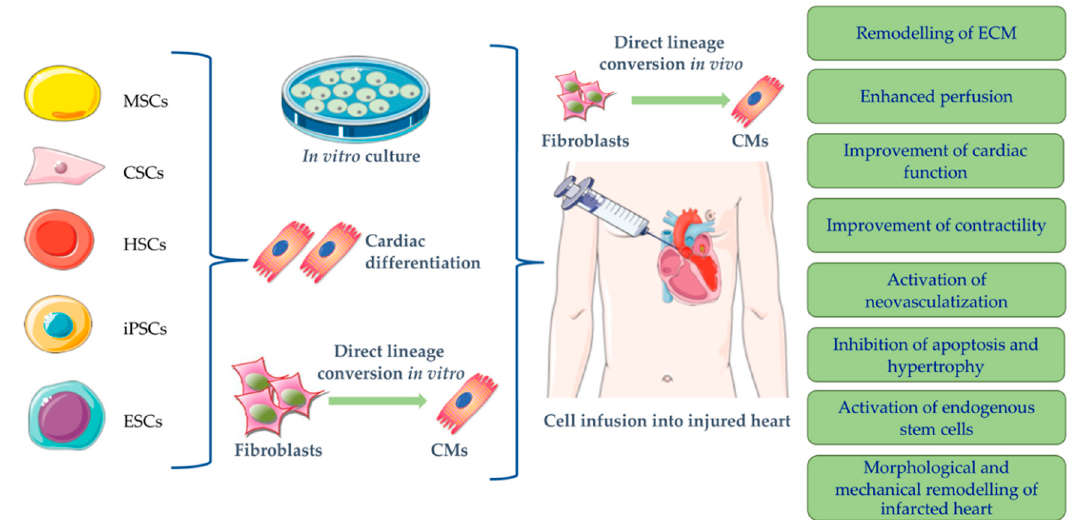
Figure 3. Cardiac regeneration.